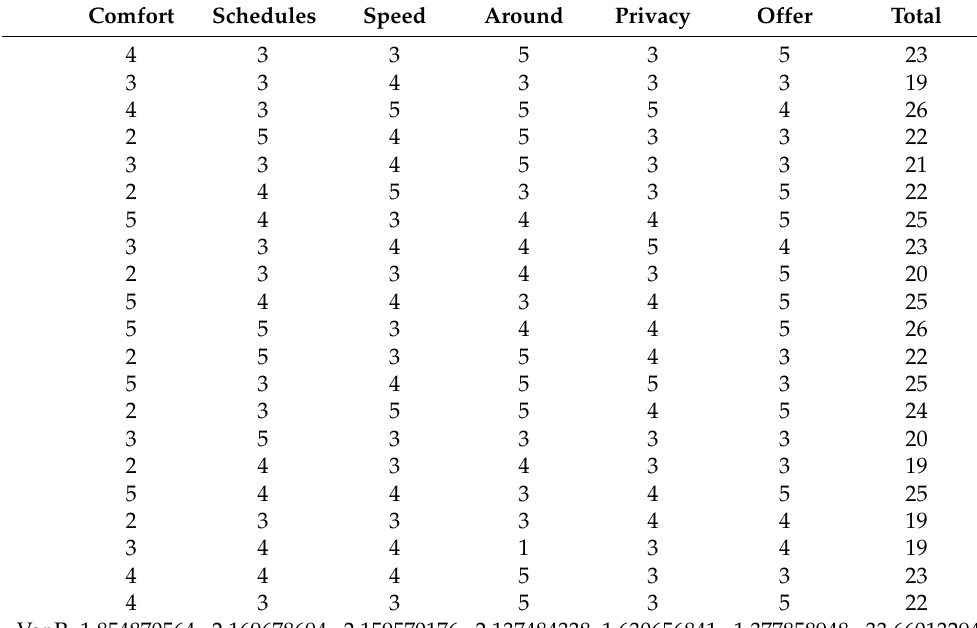
Table 7. Calculation of Cronbach’s alpha for the factors identified in the factorial analysis. Comfort Schedules Speed Around